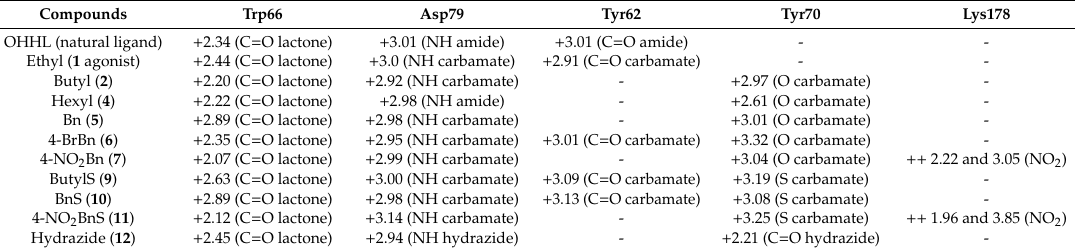
Table 2. Occurrence and distances for hydrogen bonds between Trp66, Asp79, Tyr 62, Tyr70, and the main chemical functions of studied compounds with distances (Å). + indicates a possible H-bond; the function implicated is indicated in